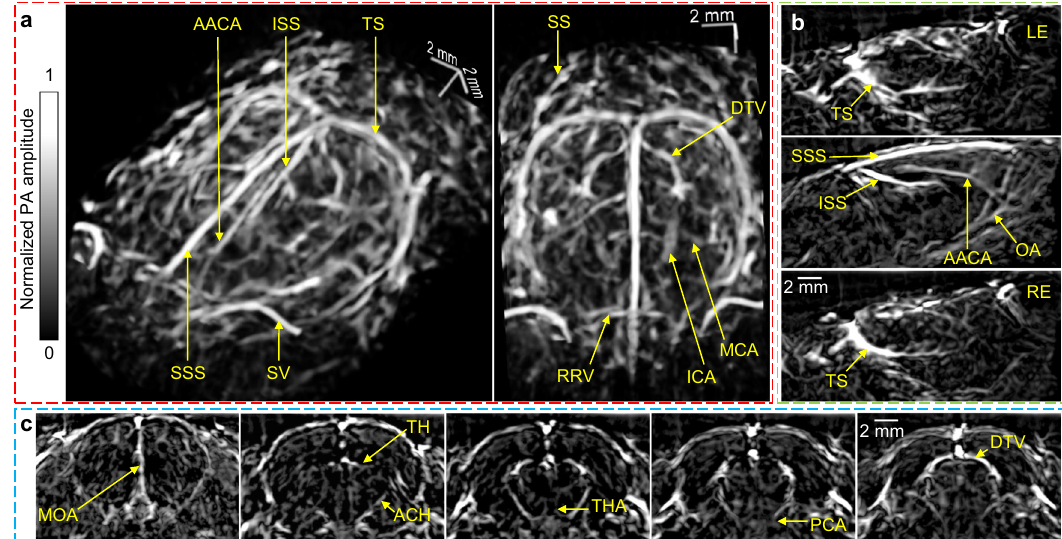
Fig. 2 3D-PACT of a rat brain in vivo. a Perspective angiograms of the rat whole brain (Supplementary Movie 1). b Cross-sectional images of the brain on different transverse planes. c Cross-sectional images of the brain on different coronal planes. AACA azygos of the anterior cerebral artery, ACH anterior choroidal artery/vein, DTV dorsal thalamic vein, ICA internal carotid artery, ISS inferior sagittal sinus, LE left eye, MCA middle cerebral artery, MOA medial orbitofrontal artery, OA olfactory artery, PCA posterior cerebral artery, RE right eye, RRV rostral rhinal vein, SS sigmoid sinus, SSS superior sagittal sinus, SV supraorbital vein, TH transverse hippocampal artery/vein; THA thalamoperforating artery, TS transverse